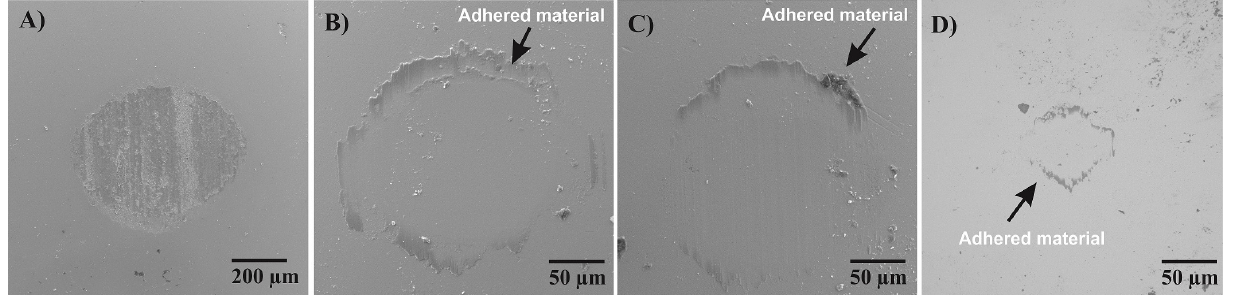
Figure 6. SEM/EDS of the Ytria stabilized zirconia spheres used during the tribological tests of the PEO coatings on Ti-6Al-4V ELI alloy processed by L-PBF obtained in the different voltages: ( A ) Ti6Al4V-AM, ( B ) TiAM-PEO 200v , ( C ) TiAM-PEO 250v and ( D ) TiAM-PEO 300v .